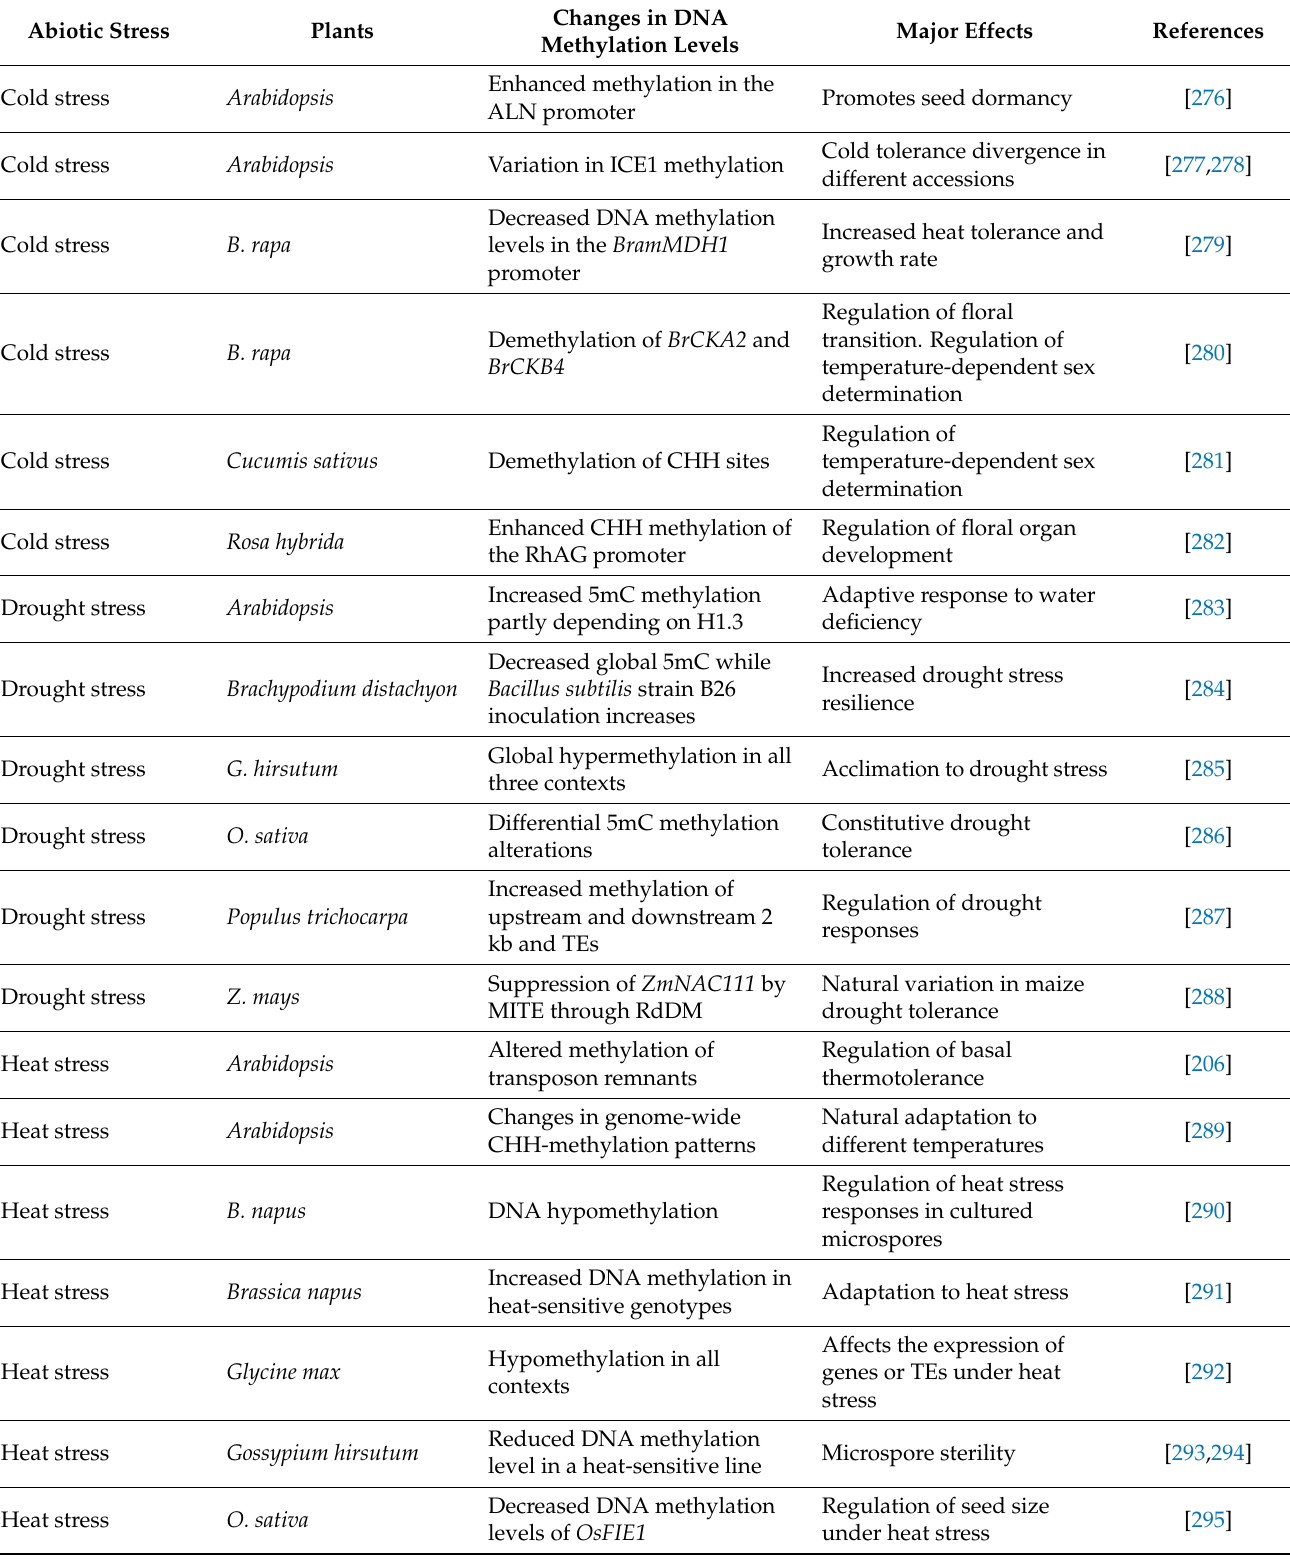
Table 4. Various roles of DNA methylation in plant responses to abiotic stresses